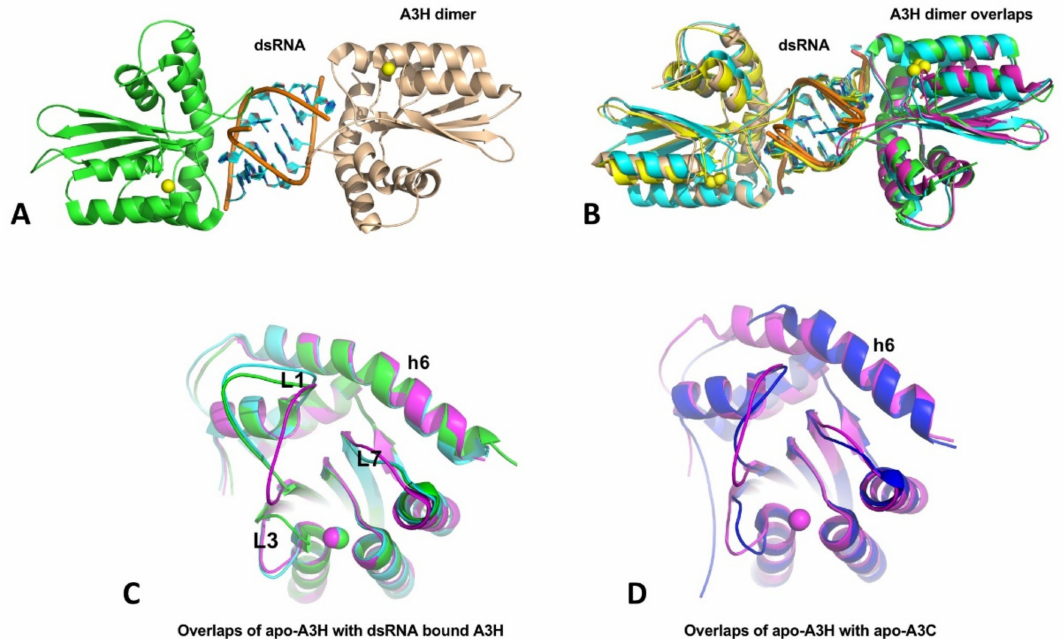
Figure 6. The crystal structures of A3H and dimer formation through dsRNA binding. ( A ) The A3H dimer (5W3V) with two subunits being connected through a dsRNA bound in between. No protein-protein contact exists between the two subunits within a dimer. ( B ) Superimposition of three available A3H dimers from three different organisms (5W3V, 6BBO, 5Z98), showing highly conserved dimerization mechanisms. ( C ) Superimposition of apo-A3H monomer structure with one subunit from the A3H dimers (5W45, 5W3V, and 5Z98), showing that conformational differences only for loops 1, 3, and 7, which are directly involved in dsRNA binding. ( D ) Superimposition of apo-A3H (5W45) and apo-A3C (3VOW) reveal that A3H has two extra alpha-helical turns for h6, compared to A3C and all other known APOBEC